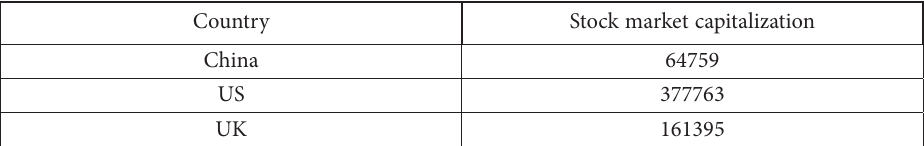
Table 3. Comparison of the market capitalization of China, US and UK in 2018 (unit: hundred million US